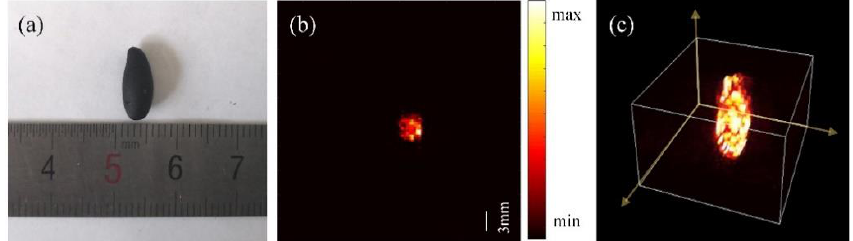
Figure 10. ( a ) Photograph of a tumor phantom, ( b ) PA image of a B-scan, and ( c ) three-dimensional photoacoustic image.